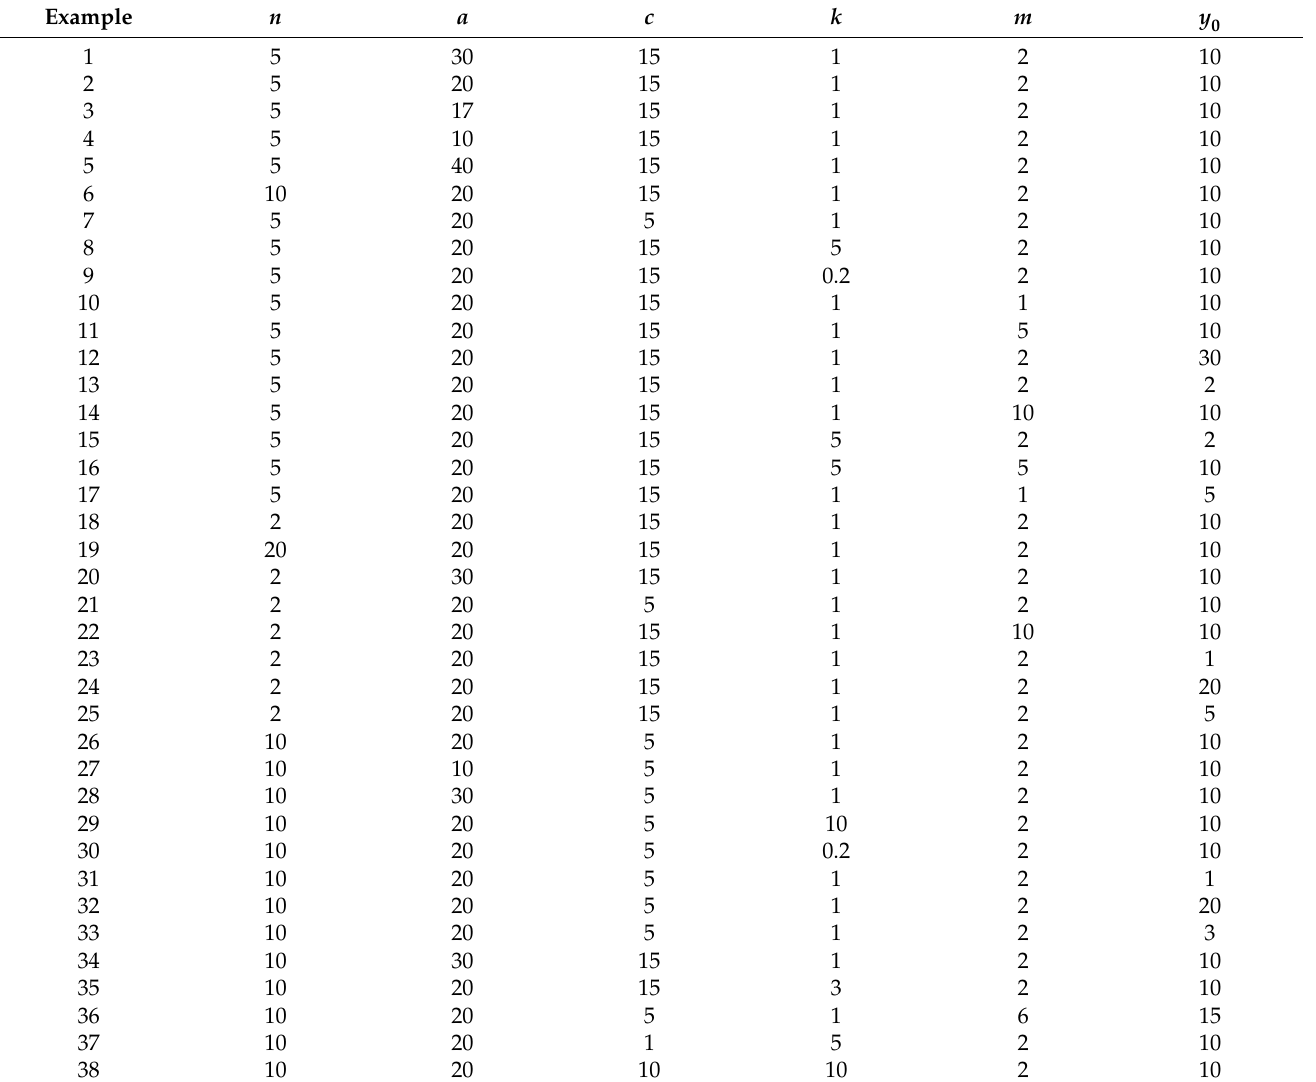
Table 1. Input data in the case of symmetrical